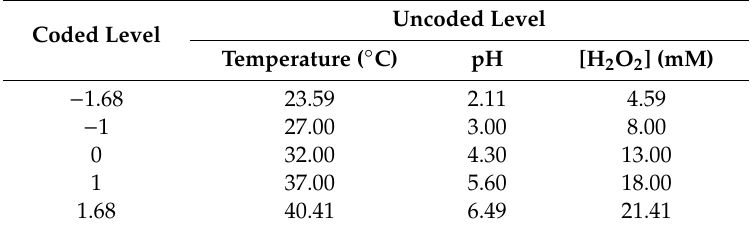
Table 1. Experimental variables and levels for central composite design (CCD), [H 2 O 2 ]: H 2 O 2 concentration. Uncoded Level Coded Level Temperature ( ◦ C)